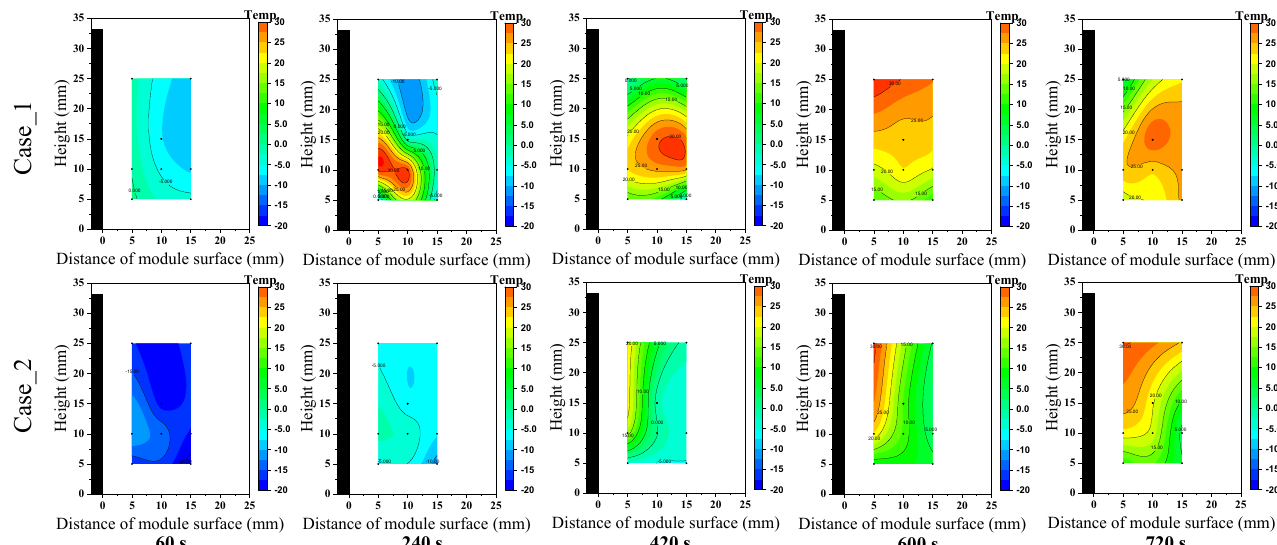
Figure 12. Temperature distribution around heating module (Module_2): Case_1 vs. Case_2. This is because, in Case_1, heat from the outside affected the temperature in the relevant area, but in Case_2, only the heating module and the solution in the frozen state affected the